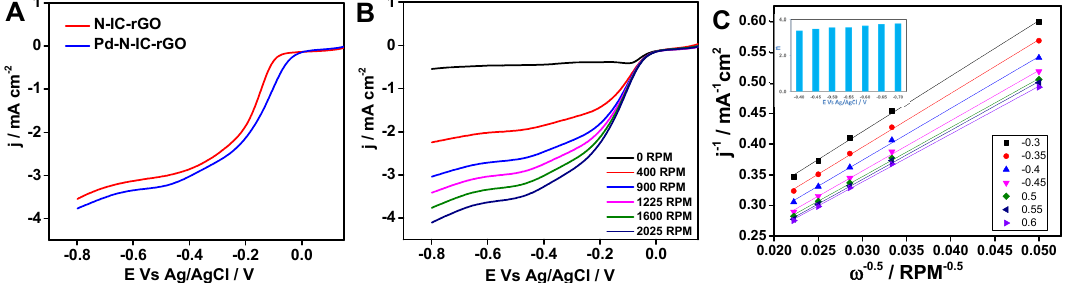
Figure 9. ( A ) Linear sweep voltammogram carried out in 0.1 M KOH at a scan rate of 0.005 V s − 1 at 1600 revolutions per minute (RPM). ( B ) Linear sweep voltammogram carried out in 0.1 M KOH at a scan rate of 5.0 mV s − 1 at different rotating speeds Pd-N-IC-rGO. ( C ) K-L plots constructed using data from C (insert: number of electrons transferred at different potentials determined from K-L plots).